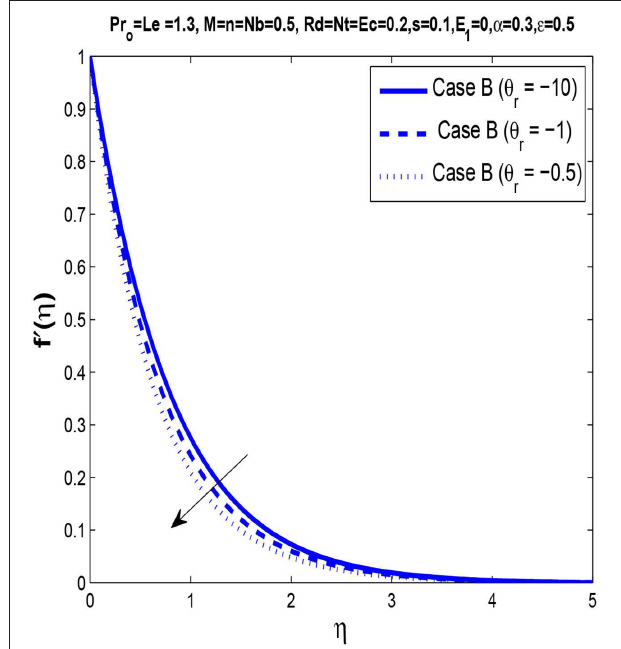
FIGURE 2 | Velocity f ′ ( η ) for different values of E 1 .